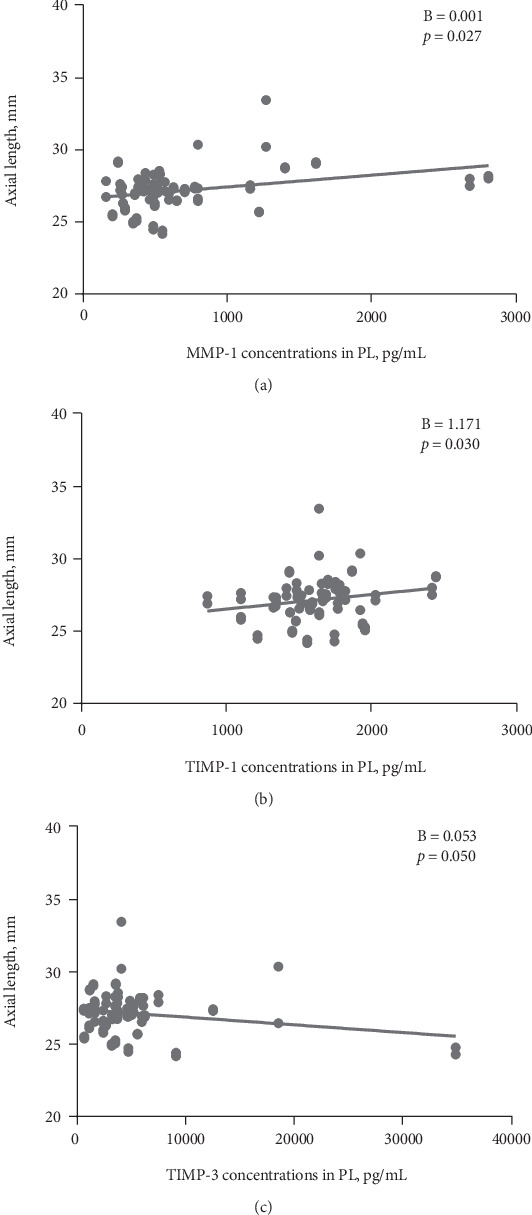
Scatter plots of concentrations of MMP-1 (a), TIMP-1 (b), and TIMP-3 (c) levels in plasma samples, plotted against the axial length.